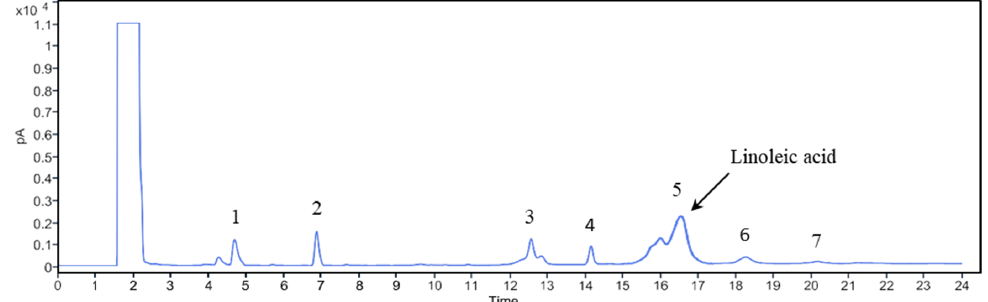
Figure 3. GC chromatogram of TOFAs. (1) Palmitic acid (C16:0), (2) Palmitoleic acid (C16:1), (3) Oleic acid (C18:1), (4) Stearic acid (C18:0), (5) LA (C18:2n6), (6) GLA (C18:3n6), (7) ALA (C18:3n3).